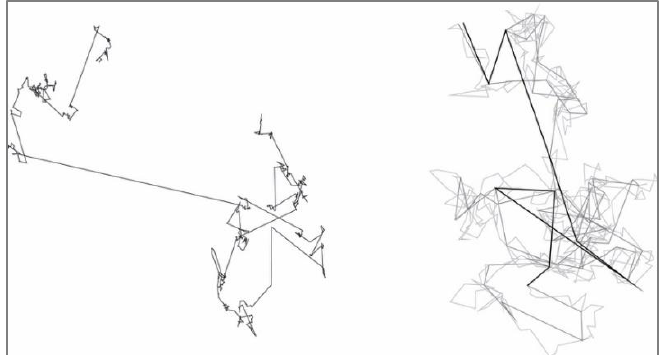
Figure 8 Lévy flight (left) and Brownian walk (right) search patterns; the Lévy flight is based on a mix of longer jumps between local searches, whereas the Brownian walk tend towards a more consistent distance. The figure of Brownian walk shows patterns from three different step lengths. Hillier’s argument is that the foreground network in part operates by enabling ‘local’ searches in di stant places — similar to how Lévy flight search patterns work —rather than forming a network of origins and destinations ‘of its own’. Figures adapted from Wikimedia Commons, Public domain